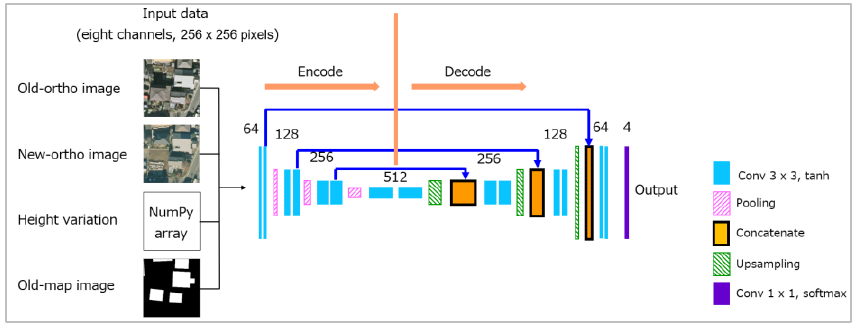
Figure 1. Network